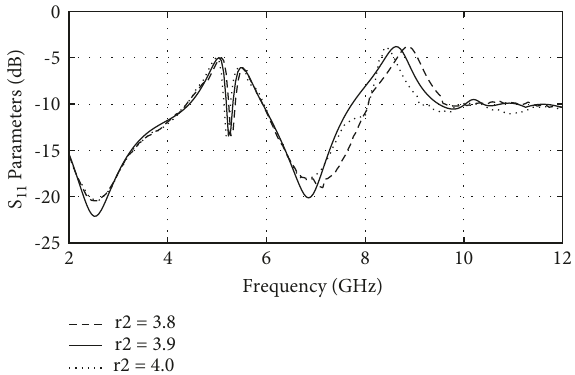
Figure 3: Different values of radius r